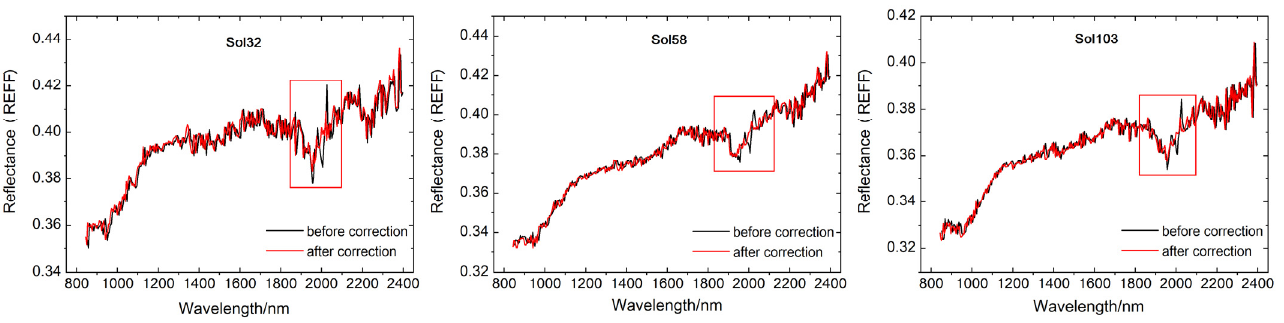
Figure 9. Reflectance curve of white panel REFF before and after spectral calibration (black curve indicates before calibration; red indicates after calibration).